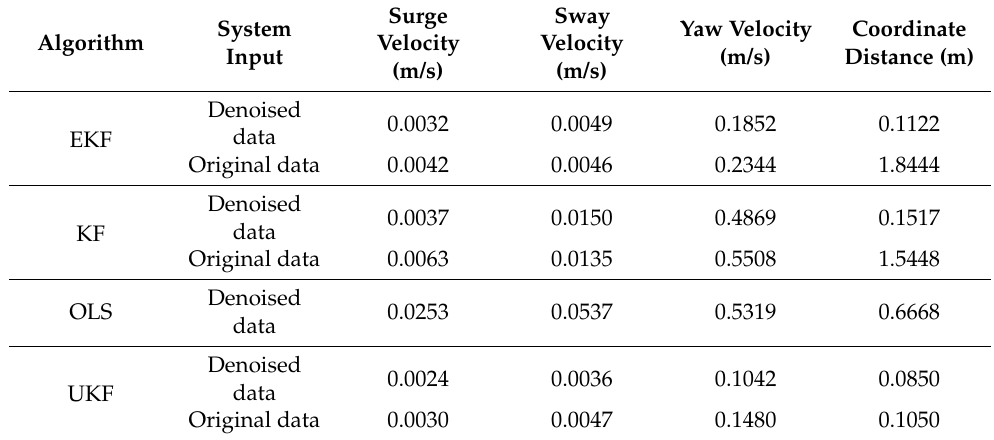
Table 2. The error mean of each algorithm in the entire identification